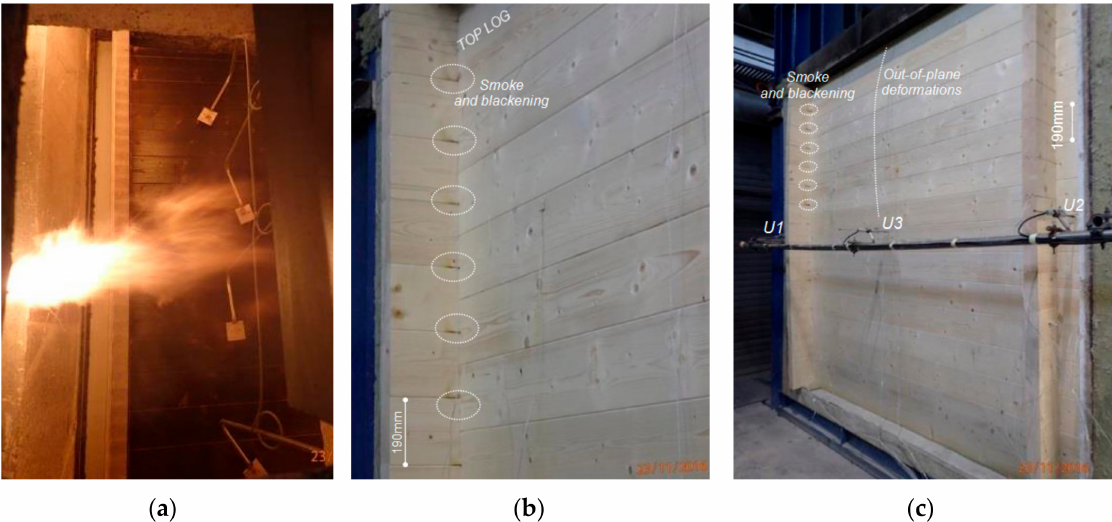
Figure 3. Fire test observations for the W80 specimen, after ( a ) 2 min (internal side); ( b ) 35 min (external side) and ( c ) 50 min (external) of EN/ISO standard time-temperature